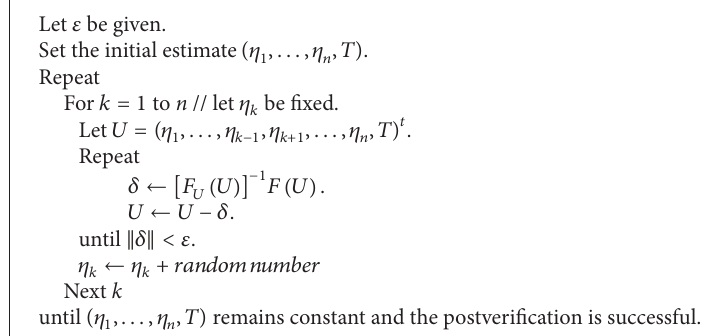
Algorithm 3: The postverification method.